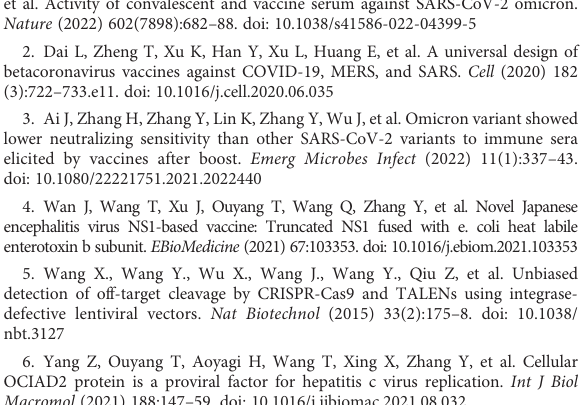
SUPPLEMENTARY FIGURE 2 Identi fi cation of pre-coated recombinant RBDs by anti-His tag antibody. Recombinant RBDs were examined by ELISA assays with anti-His tag antibody, vaccine serum (participant ID: 31-1), and unimmunized sera (UC-sera, participant ID: 62-1), or